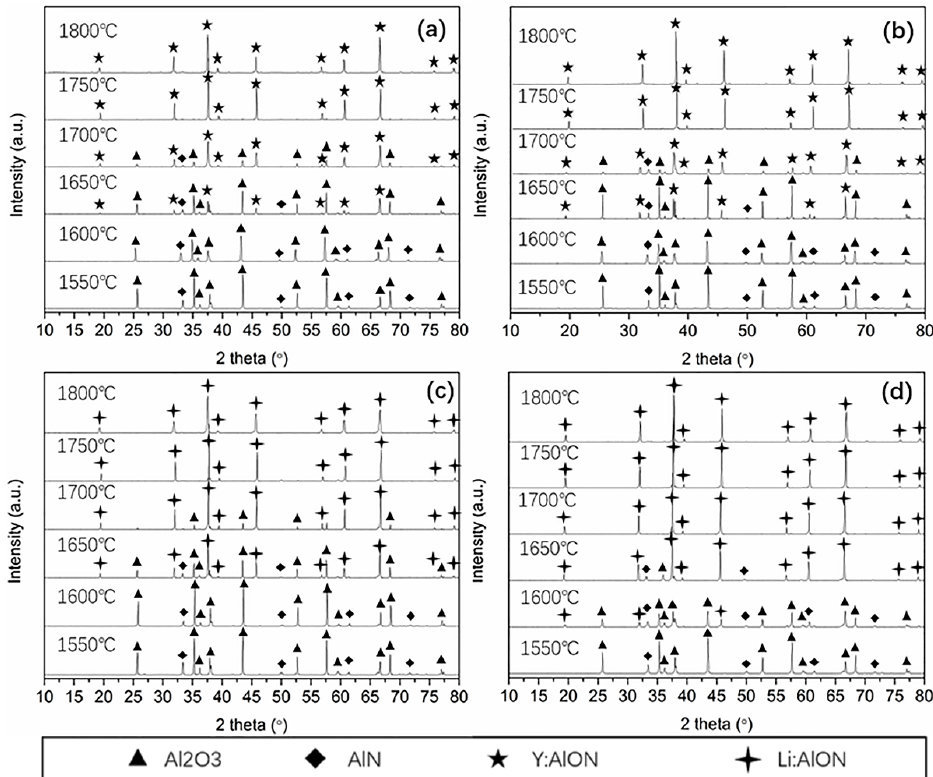
Figure 2. XRD of the ceramics sintered under different temperatures: ( a ) AlN–Al 2 O 3 –0.5% Y 2 O 3 ; ( b ) AlN–Al 2 O 3 –1.0% Y 2 O 3 ; ( c ) AlN–Al 2 O 3 –10% LA and ( d ) AlN–Al 2 O 3 –20% LA.